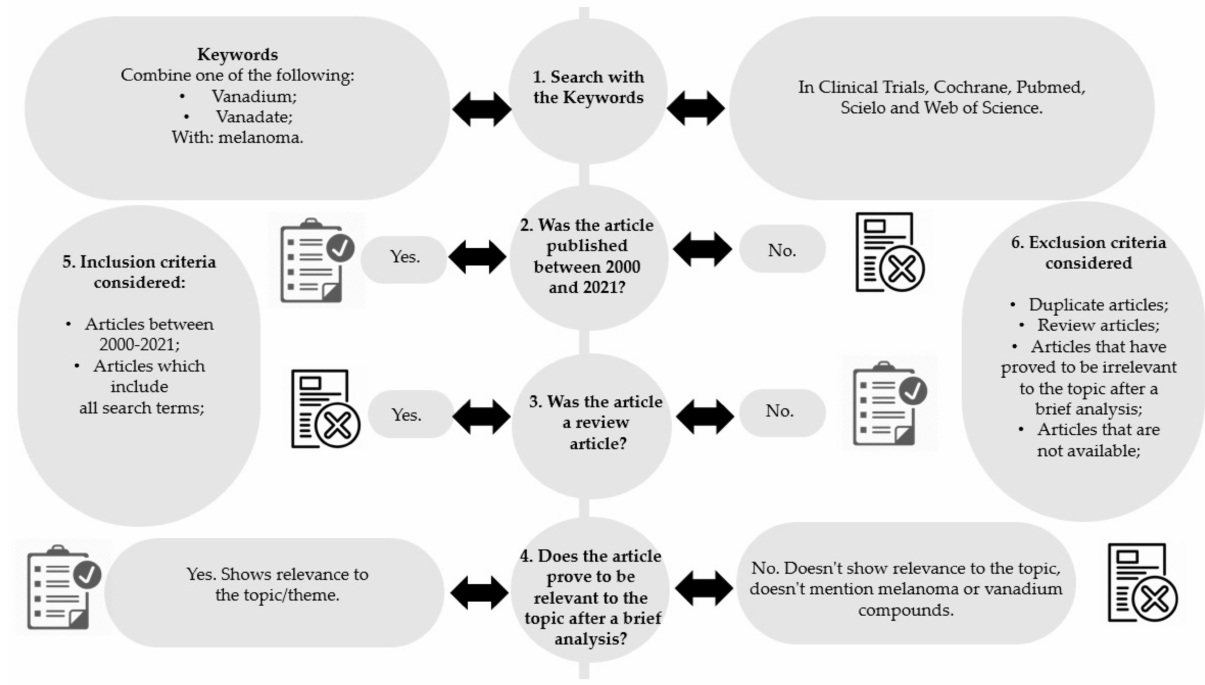
Figure 2. Methodology diagram of the articles’ selection